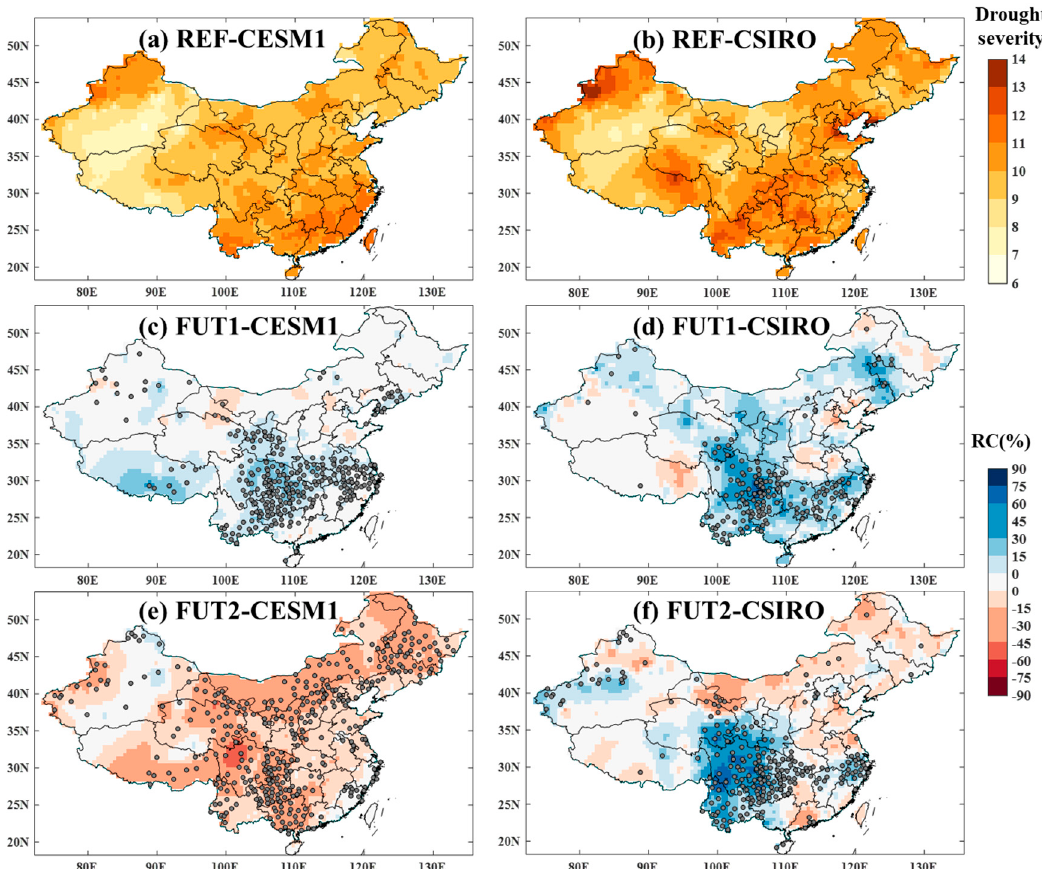
Figure 10. Spatial patterns of drought severity with a 50-year return period in the reference period (REF) and the relative changes (RC) in future periods (FUT1, FUT2) for two climate model ensembles. Stations that present statistically significant changes are marked with filled dots. ( a )The 50-year return period of drought severity in REF for CESM1; ( b ) The 50-year return period of drought severity in REF for CSIRO; ( c ) The RC of the 50-year return period of drought severity in FUT1 for CESM1; ( d ) The RC of the 50-year return period of drought severity in FUT1 for CSIRO; ( e ) The RC of the 50-year return period of drought severity in FUT2 for CESM1; ( f ) The RC of the 50-year return period of drought severity in FUT2 for CSIRO.